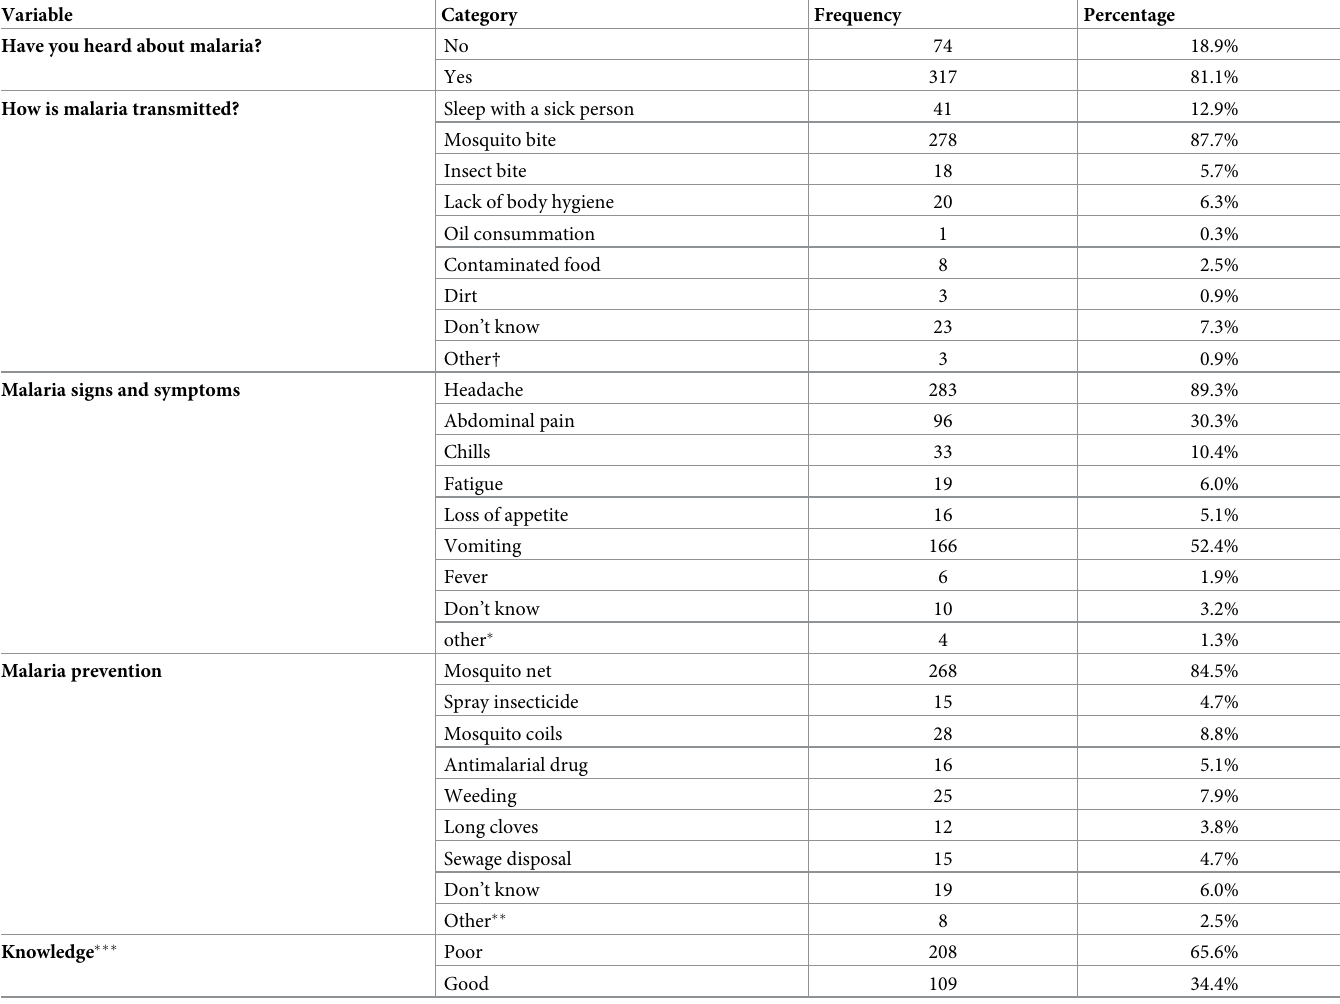
Table 2. Participant knowledge of malaria transmission, signs and symptoms, and prevention